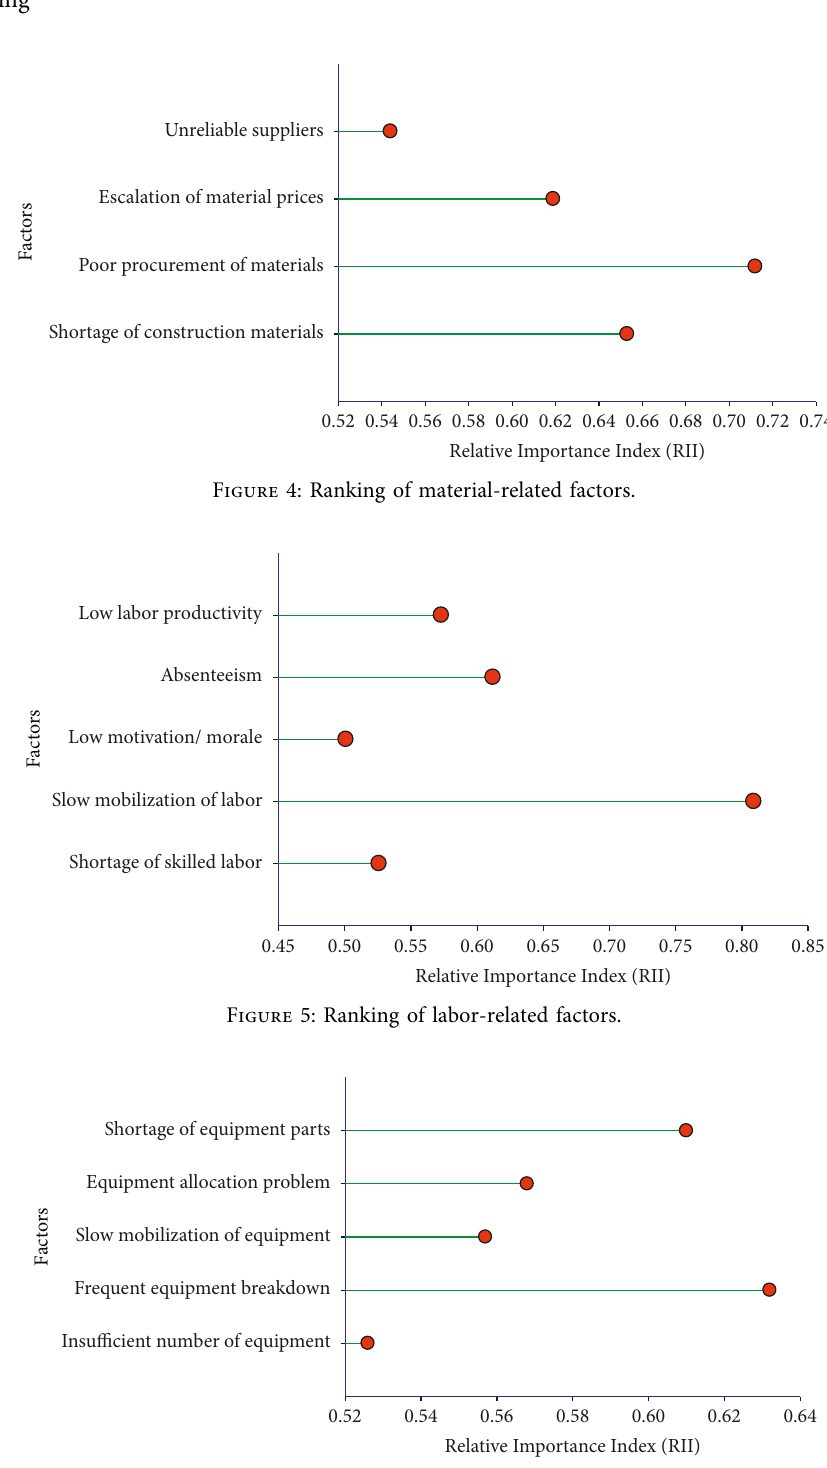
Figure 6: Ranking of equipment-related